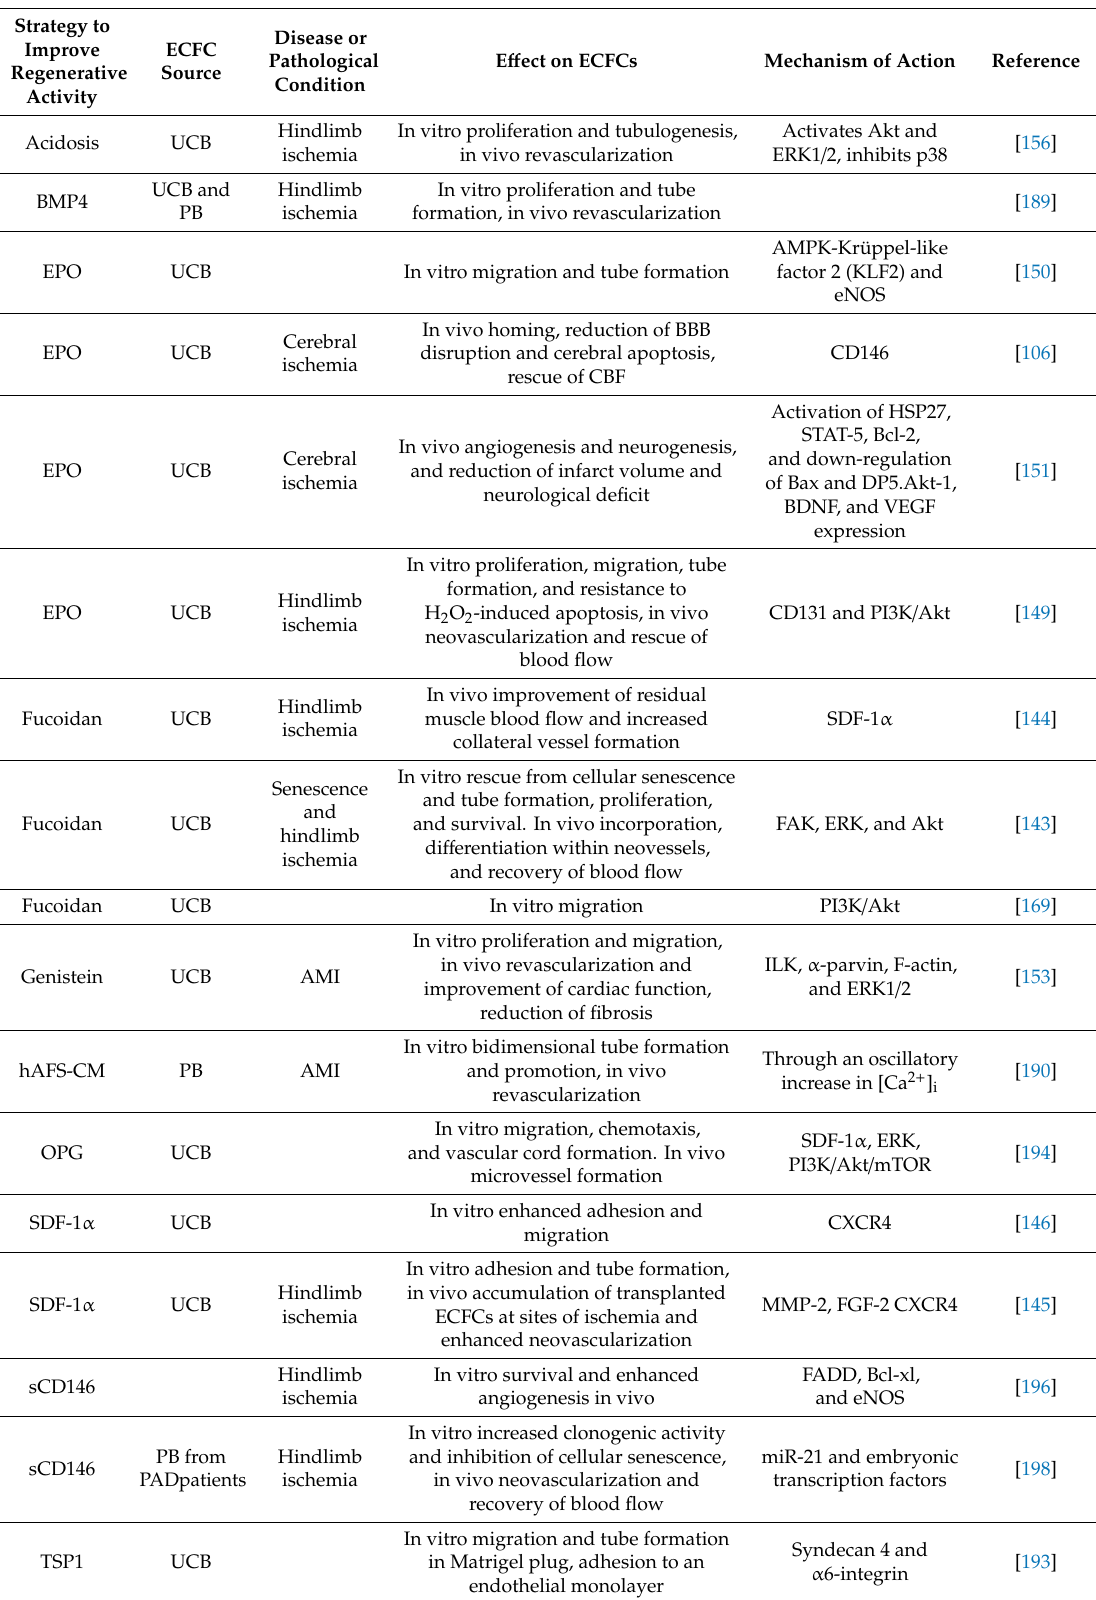
Table 4. Strategies to enhance angiogenic activity of healthy ECFCs.